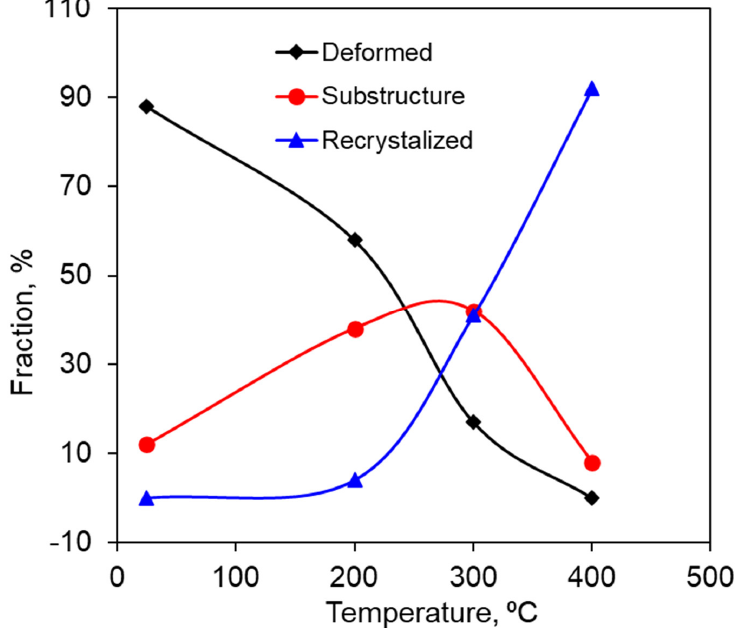
Figure 3. Effect of the annealing temperature on the fraction of different types of grains of the AA7075 coating deposited on the AZ31B Mg alloy in the cold spray process.